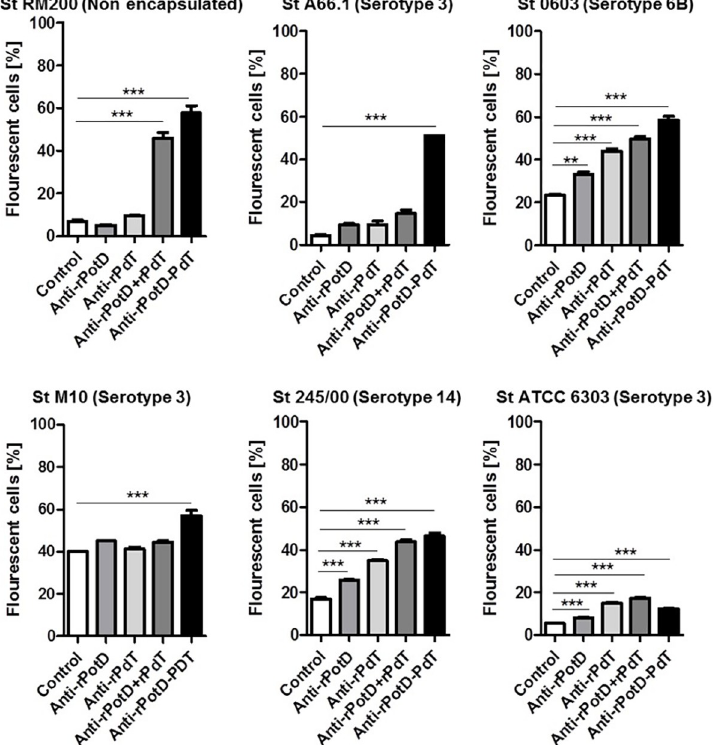
Fig 4. Antibody binding to the pneumococcal surface. Pneumococcal strains St RM200, St A66.1, St 0603, St M10, St 245/00 and St ATCC6303 were incubated with anti-sera from mice immunized with rPotD, rPdT, rPotD + rPdT, rPotD-PdT or the adjuvant alone in saline (control), followed by incubation with anti-IgG mouse conjugated with FITC and analyzed by FACS. The percentage of fluorescent bacteria (10 1 fluorescence intensity units) was calculated for each sample. ��� p < 0.001; �� p < 0.01; � p < 0.05. The values correspond to the mean + SD of five serum samples for each